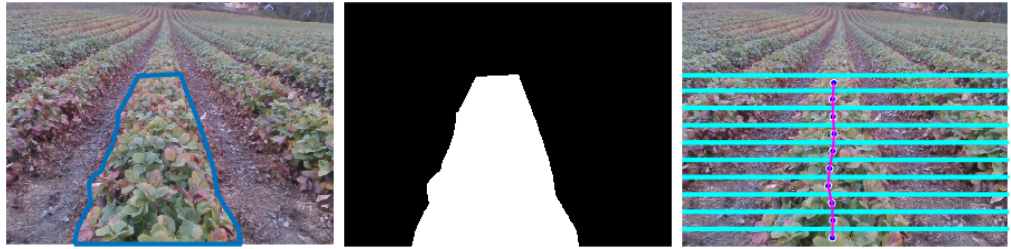
Figure 10. Ground Truth Centerline by manual annotation. The left image is the raw RGB image from the camera. The middle image is the binary mask generated by freehand masking; the final image corresponds to the centerline of the crop row as ground truth (pink).